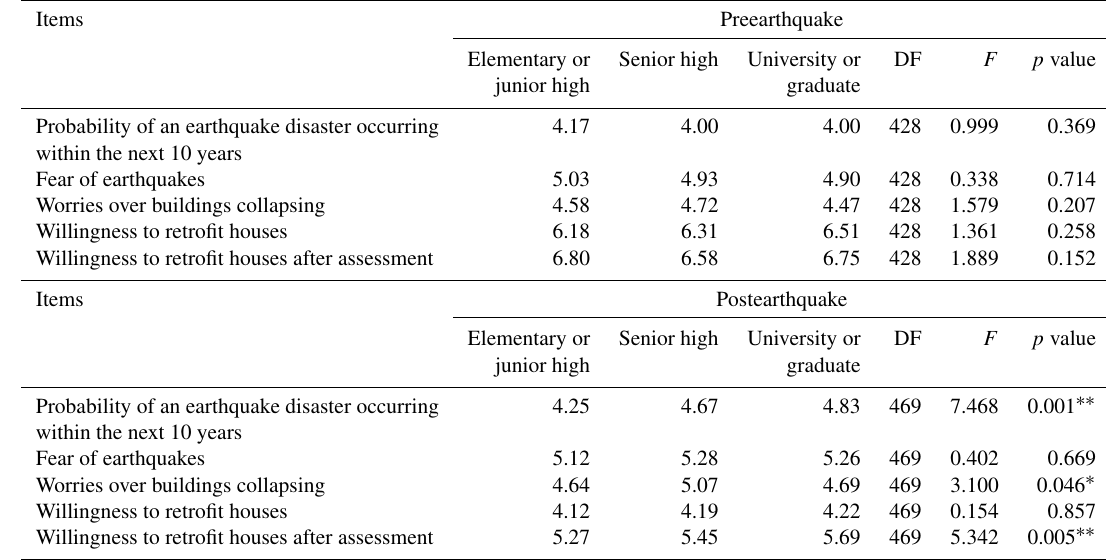
Table 5. p values and means for education. Items